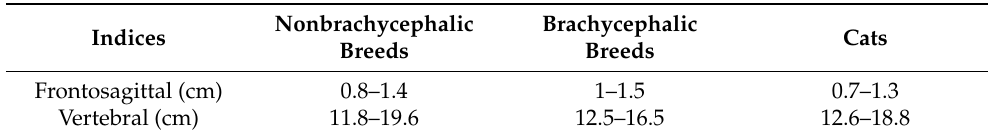
selected vertebra to the nearest point of the sternum ( b ) and the dorsoventral diameter of the center of the same vertebra ( c ) (Adamovich-Rippie figure; Culp, 2016 [16]). Table 1. Frontosagittal and vertebral thoracic indices in dogs of nonbrachycephalic breeds, brachy- cephalic breeds and cats [16].